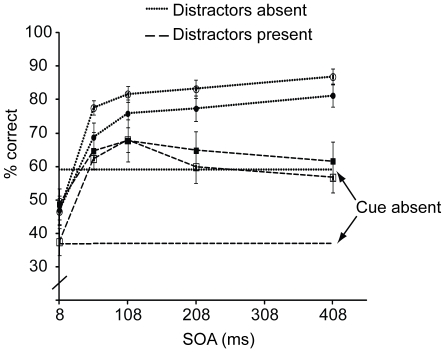
Target identification accuracy for Experiment 1 (filled symbols) and 1b (open symbols), plotted as a function of SOA, cue and distractor presence.The error bars represent the standard error of the mean.